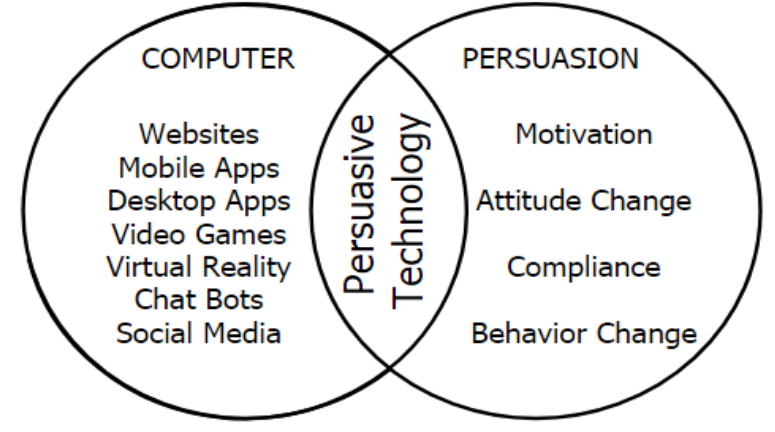
Figure 1. Persuasive Technology dubbed “Captology” [32] .